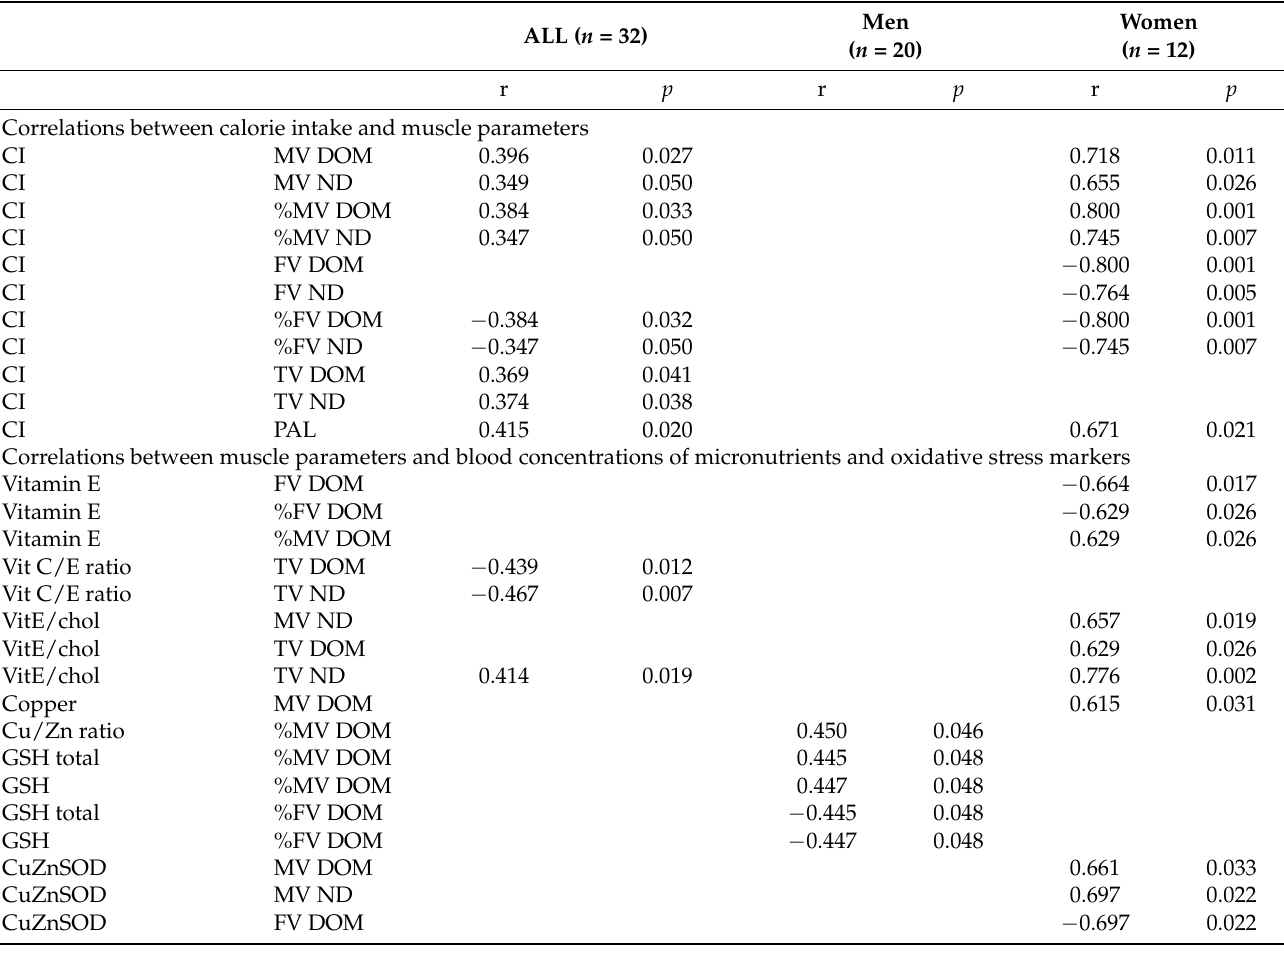
Table 15. Correlations in 32 patients with